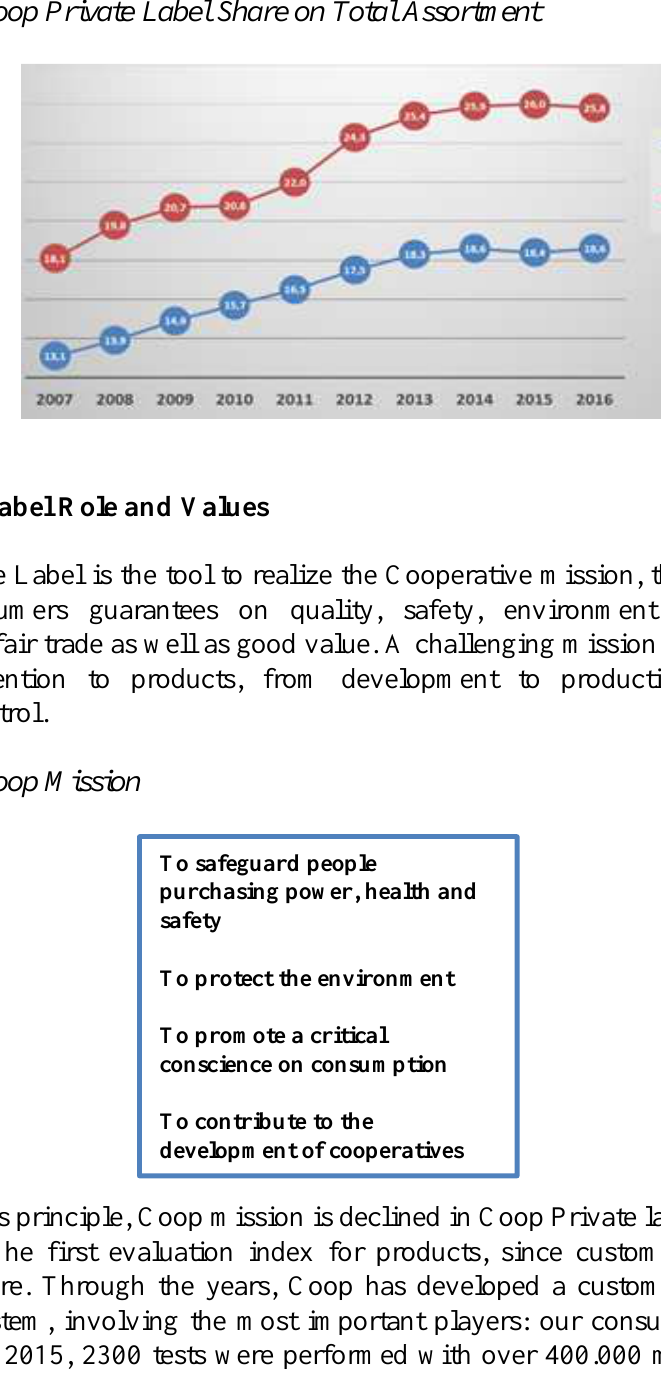
Figure 1: Coop Private Label Share on Total Assortment